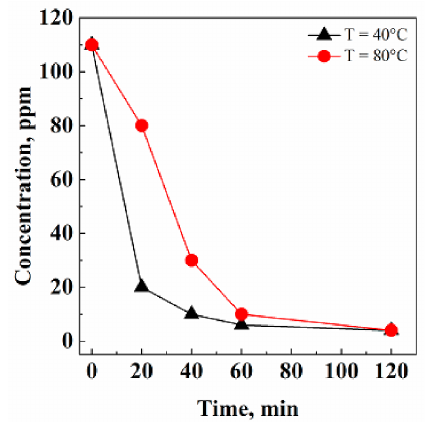
Figure 3. Effect of temperature on acetone residual concentration in Fluni, investigated at 200 bar and 0.7 kg/h CO 2 flow rate.